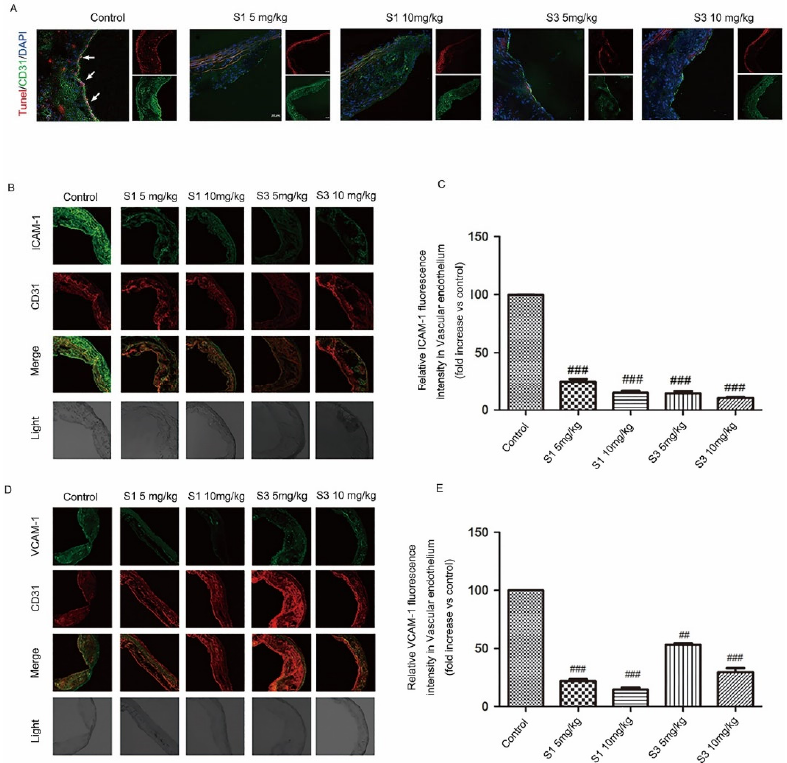
Figure 3. Compounds S1 and S3 inhibited endothelium apoptosis and the protein level of ICAM ‐ 1 and VCAM ‐ 1 in apoE ‐ / ‐ mice. ( A ) Sections from aortic roots of apoE ‐ / ‐ mice were labeled by TUNEL to detect apoptotic cells in endothelium. Endothelial cells were stained with CD31 (red). Nuclei (blue) were stained with DAPI (200×). Arrow indicated the apoptotic endothelial cells. A total of 6 mice per group and 3 slides per mouse were analyzed. ( B , D ) Immunofluorescent staining of ICAM ‐ 1 and VCAM ‐ 1 in the endothelium of aortic sinus plaque of apoE ‐ / ‐ mice (200×). ( C , E ) Quantification of ICAM ‐ 1 and VCAM ‐ 1 protein level in endothelium of 6 mice per group and 3 slides per mouse. Data were analyzed by an unpaired two ‐ sided Student’s t ‐ test. ## p <0.01, ### p <0.001 vs. control.